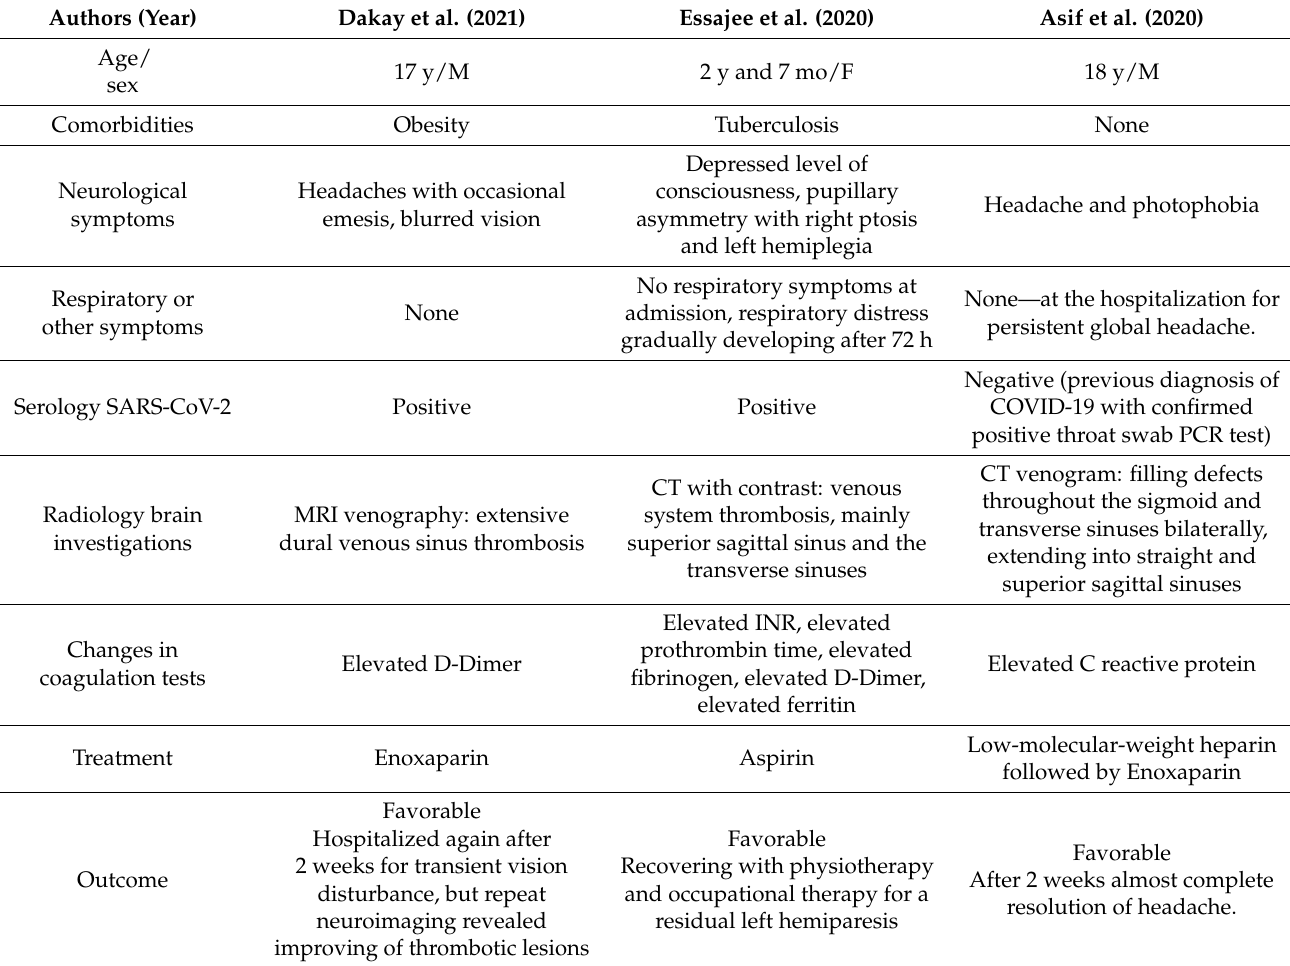
Table 2. Reported cases of cerebral venous thrombosis during COVID-19 infection in children